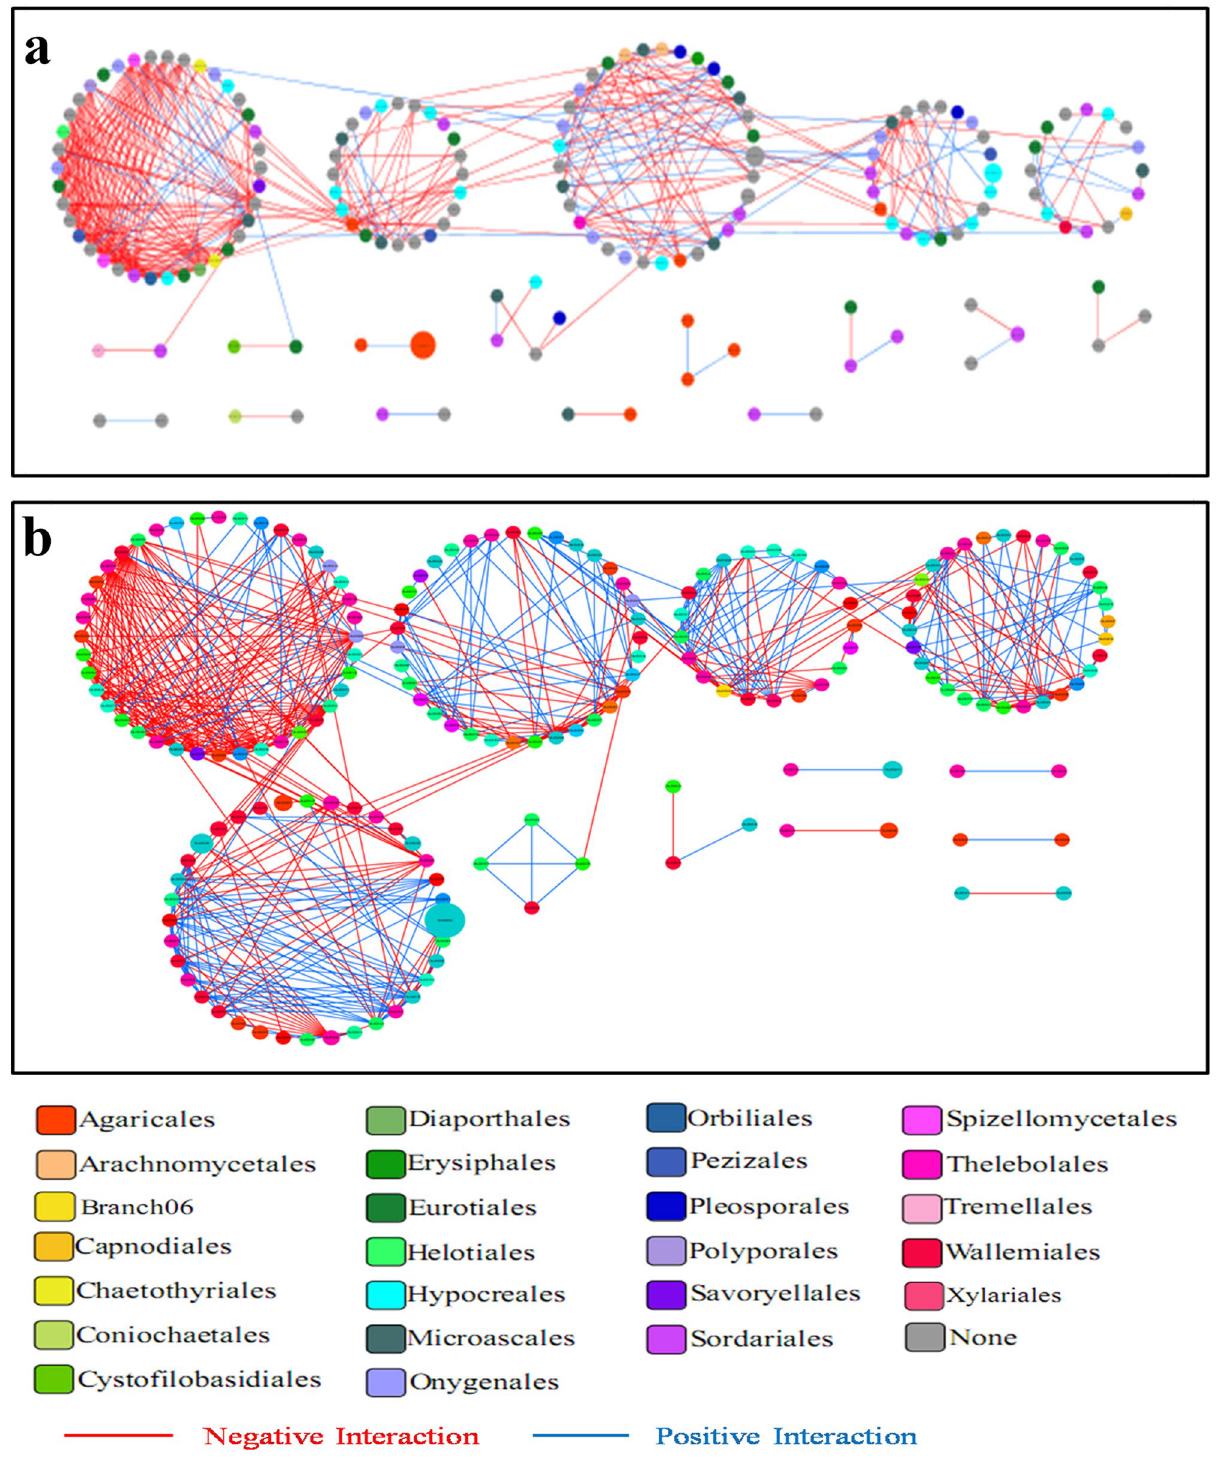
Figure 6. Network plots of fungal community at the order level from soil without (CK1) ( a ) and with (T1) ( b ) wheat straw addition at the watermelon flowering stage. The size of the node corresponds to the relative abundance of the OTUs. The node colors show various phylogenetic associations. Node (edge) connection lines represent co-occurrence with positive (blue) and negative (red)